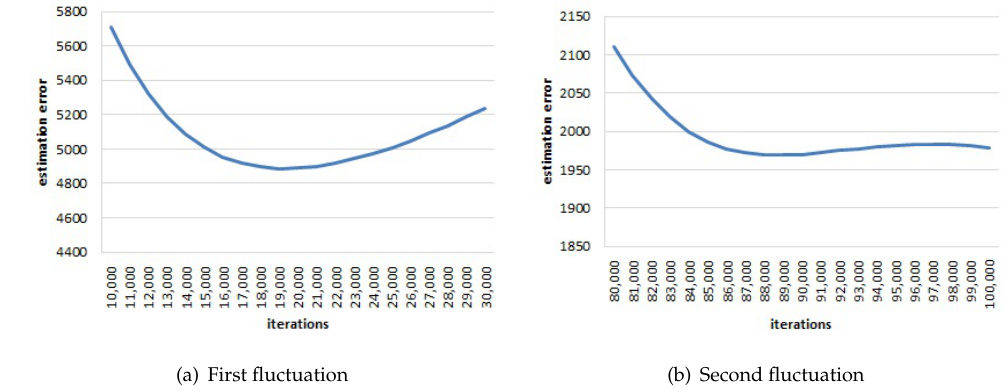
Figure 8. ( a ) The first fluctuation: the estimation error increases after about 19,000 iterations. ( b ) The second fluctuation: the estimation error increases after about 89,000